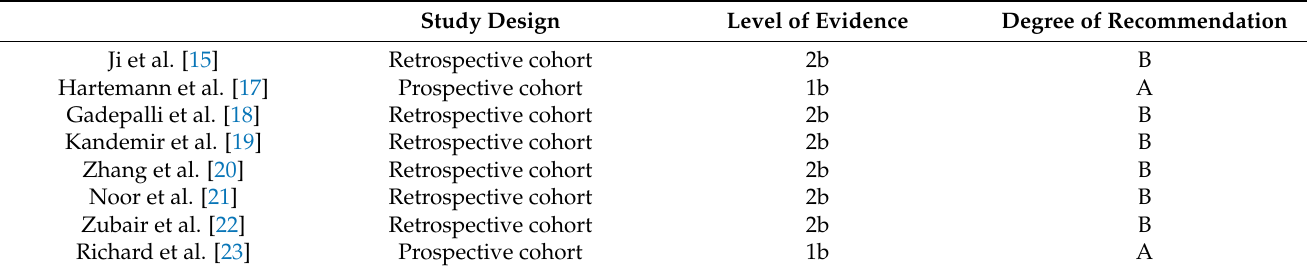
Table 1. Levels of evidence and degree of recommendation for the included studies.